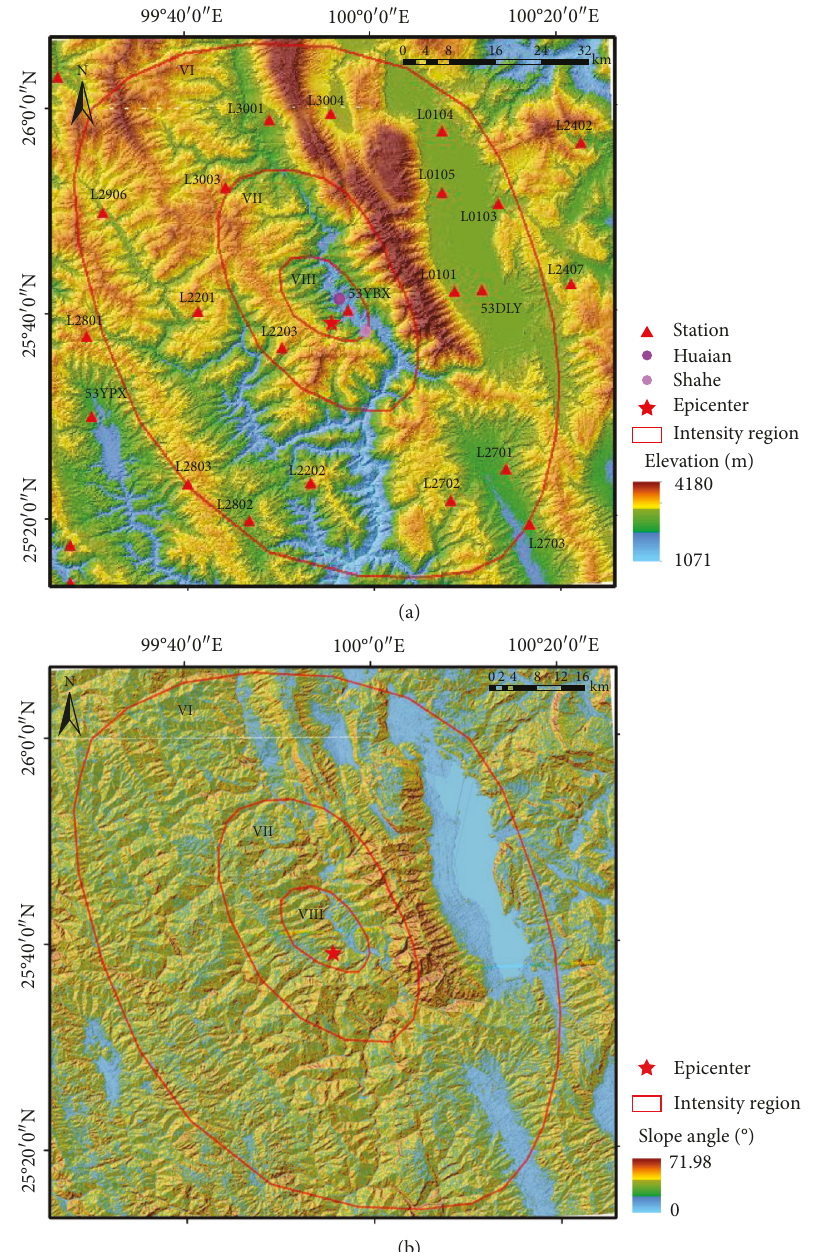
Figure 2: Distribution of elevation, slope angle, and intensity map in Yangbi earthquake. (a) Elevation and intensity map. (b) Slope angle and intensity